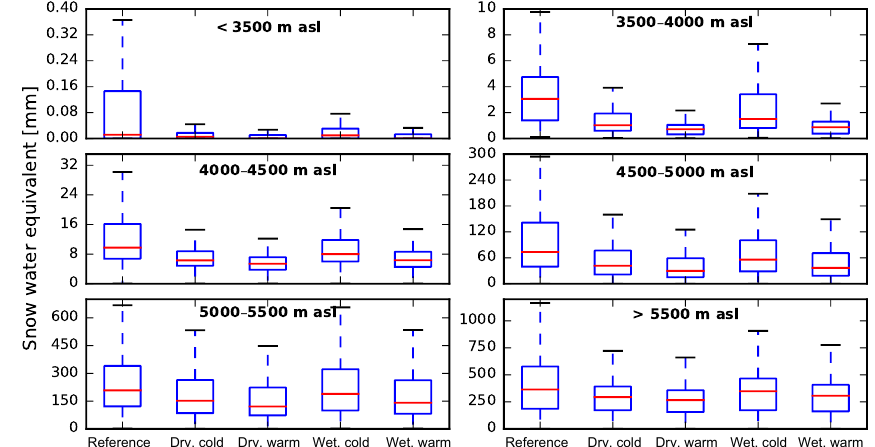
Figure 7. Boxplots of SWE per elevation zone averaged over the simulation period and all ensemble members for the study period (reference) and the four climate sensitivity tests (Table 3).